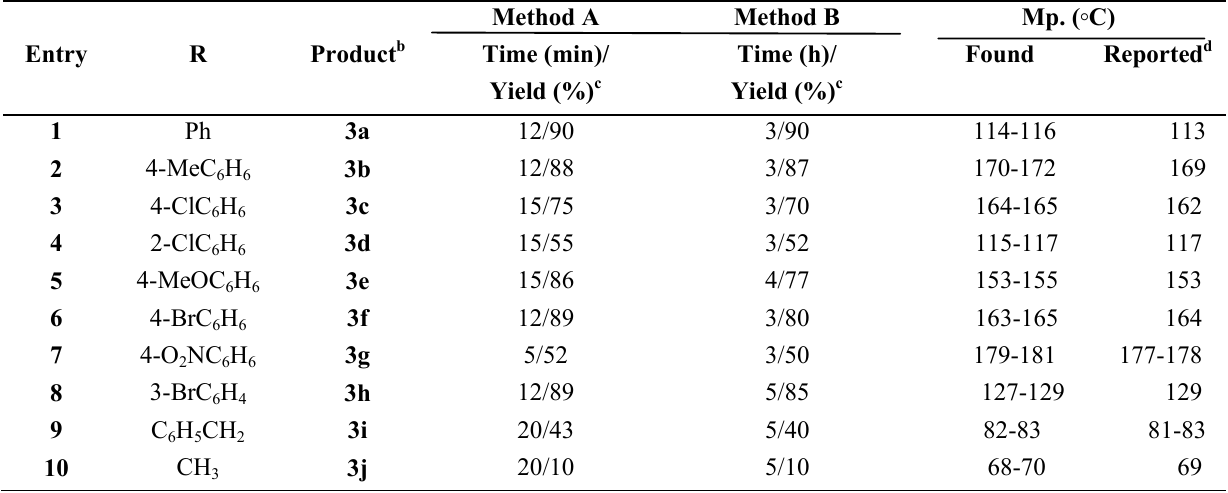
Table 2. Preparation of several 2-ketomethylquinolines 3 from acyl chlorides 2 and 2-methyl quinoline 1